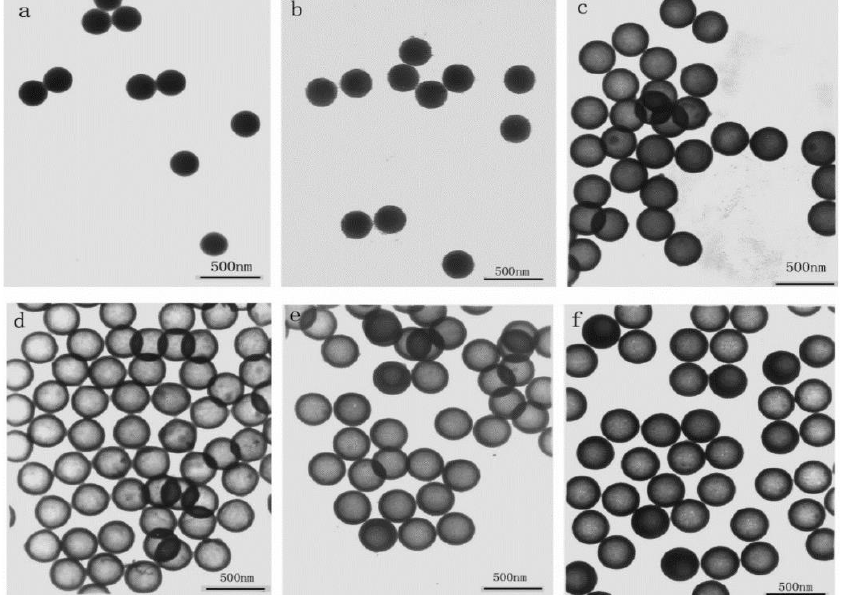
Figure 9. TEM images of ( a ) PS spheres and coated spheres obtained at different amounts of ammonia, ( b ) 0.5 mL, ( c ) 2.0 mL, ( d ) 3.0 mL, ( e ) 4.0 mL, and ( f ) 5.0 mL [78].